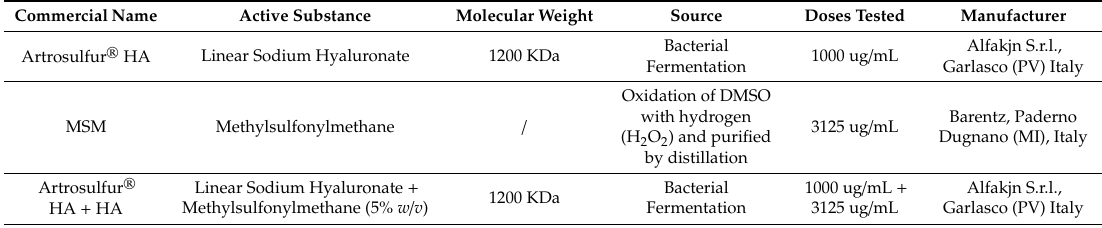
Table 1. Features of hyaluronic acid preparations tested and